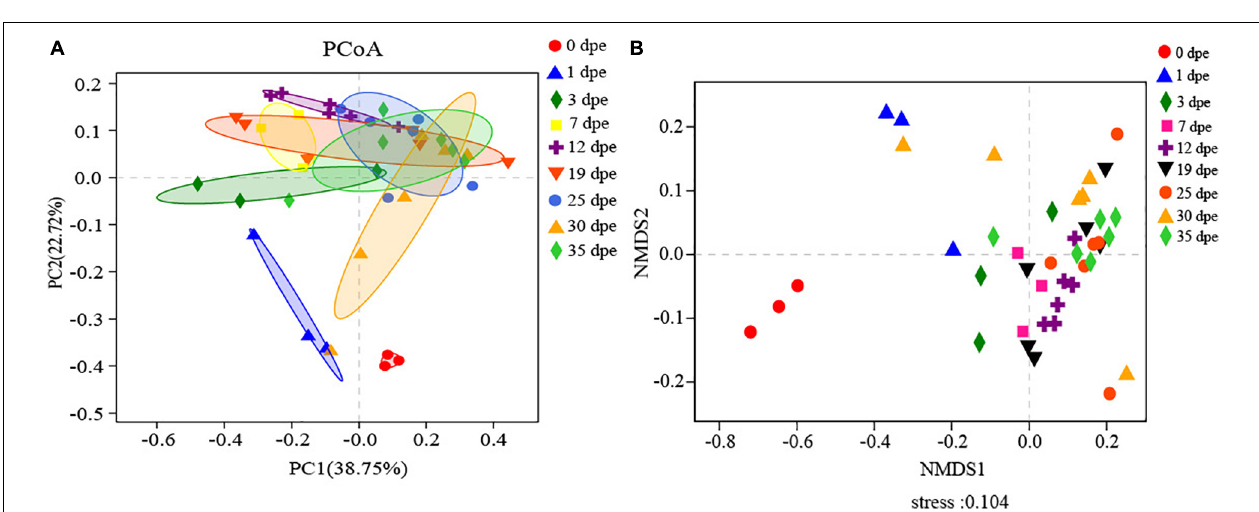
FIGURE 2 | The vertical axis represents the species names at genus classification level, the corresponding column length represents the average relative abundance of the species in various groups, and different colors represent different groups. On the far right is the value of P , *0.01 < P ≤ 0.05, **0.001 < P ≤ 0.01, *** P ≤ 0.001.